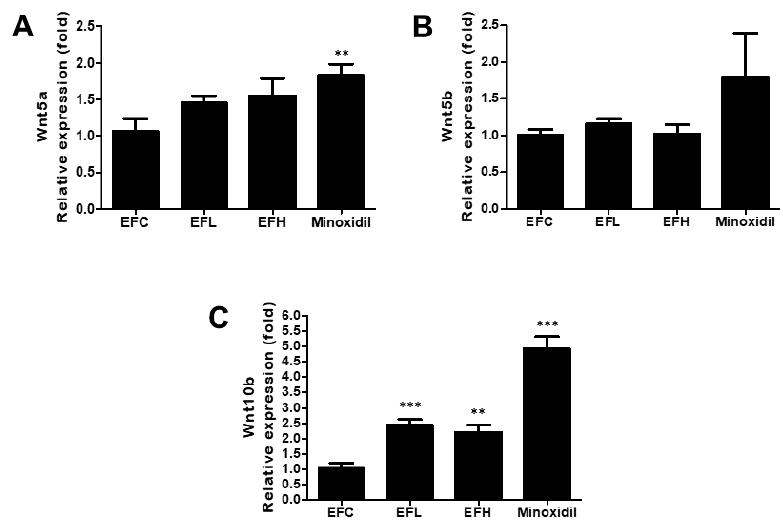
Figure 5. The effect of EF-2001 on the mRNA expression of hair-growth-related genes, including ( A ) Wnt5a, ( B ) Wnt5b, and ( C ) Wnt10b , in C57BL/6 male mice. Quantitative PCR analysis of the mRNA expression of Wnt5a, Wnt5b, and Wnt10b in the EFC-, EFL-, EFH-, and minoxidil-treated groups. ** p < 0.01, *** p < 0.001 versus EFC. Data are expressed as mean ± SD ( n = 5). 2.5. Effect of EF-2001 on the Expression of VEGF-A and VEGF-B mRNA in C57BL/6 Male Mice As shown in Figure 6, among the groups treated with EF-2001, the expression of VEGF-A was significantly higher in the EFH-treated group, and that of VEGF-B was sig- nificantly higher in the EFL-treated group compared with that in the EFC-treated group. In the minoxidil-treated group, the expression of the VEGF-B increased compared with that in the EFC-treated group. The mRNA expression was 1.02 ± 0.12, 1.05 ± 0.28, 1.66 ± 0.39, and 1.16 ± 0.20 for VEGF-A and 1.05 ± 0.38, 6.01 ± 1.26, 16.99 ± 16.14, and 38.48 ± 26.93 for VEGF-B in the EFC-, EFL-, EFH-, and minoxidil-treated groups, respectively. Figure 6. The effect of EF-2001 on the mRNA expression of hair-growth-related genes ( A ) VEGF-A and ( B ) VEGF-B in C57BL/6 male mice. Quantitative PCR analysis of the mRNA expression of VEGF- A and VEGF-B in the EFC-, EFL-, EFH-, and minoxidil-treated groups. * p < 0.05, ** p < 0.01, *** p < 0.001 versus EFC. Data are expressed as mean ± SD ( n = 5). 2.6. Effect of EF-2001 on the Expression of IGF1 and IGF1-R mRNA in C57BL/6 Male Mice As shown in Figure 7, the expression of IGF1-R was similar in the EFC-, EFL-, and EFH-treated groups. IGF1 expression significantly decreased in the EFL- and EFH-treated groups. In the minoxidil-treated group, the expression of IGF1 and IGF1-R increased com- pared with that in the EFC-treated group. The mRNA expressions were 1.01 ± 0.22, 0.68 ± 0.13, 0.56 ± 0.11, and 1.45 ± 0.27 for IGF1 and 1.08 ± 0.47, 0.93 ± 0.11, 1.31 ± 0.37, and 2.00 ± 0.51 for IGF1-R in the EFC-, EFL-, EFH-, and minoxidil-treated groups, respectively.